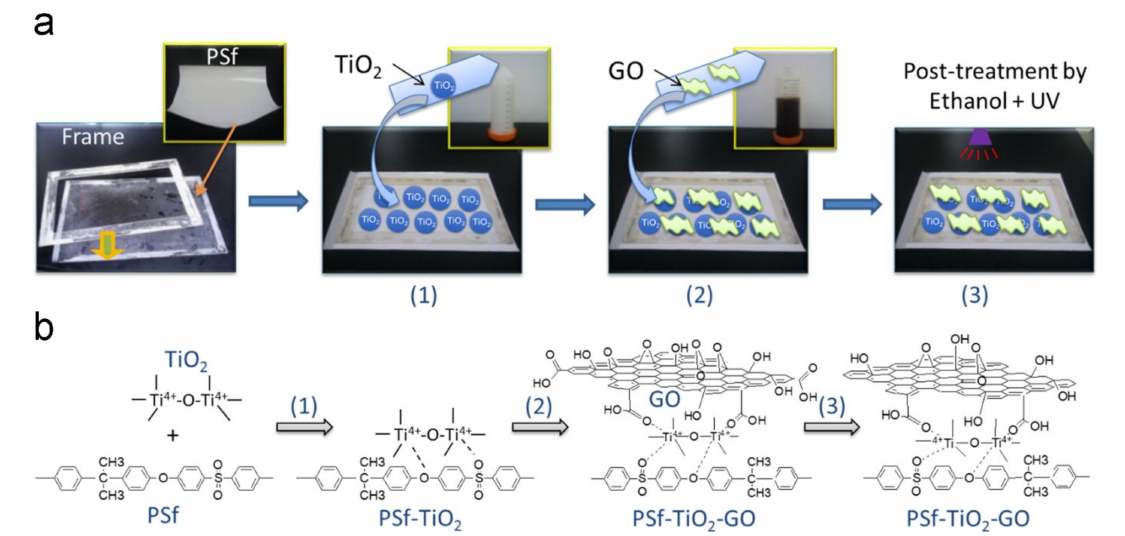
Figure 16. ( a ) Graphical illustration and ( b ) reaction schemes for the surface modification of a polysulfone (PSf) base membrane with TiO 2 –graphene oxide (GO). Reprinted from [165] with permission from